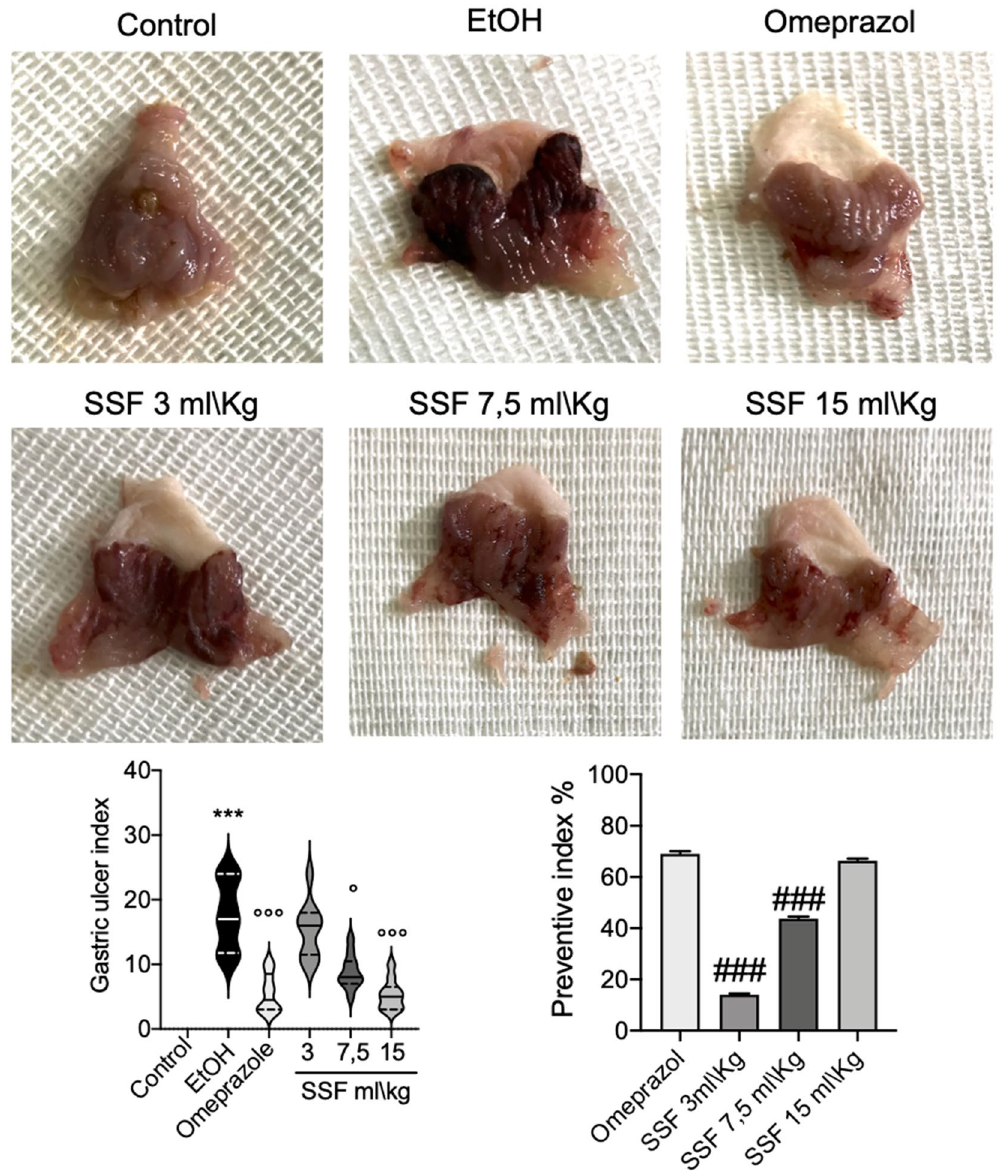
ulcer formation, instead the treatment with omeprazole at dose of 20 mg/kg significant prevent the ulceration and mucosal damage induced by EtOH. The treatment with SSF showed a dose dependent protective effect. Data are presented as means ± SEM, or median with interquartile range for non-parametric data of 10 mice for each group .***p < 0.001 versus control; ◦ p < 0.05 versus EtOH; ◦◦◦ p < 0.001 versus EtOH; ###p < 0.001 versus